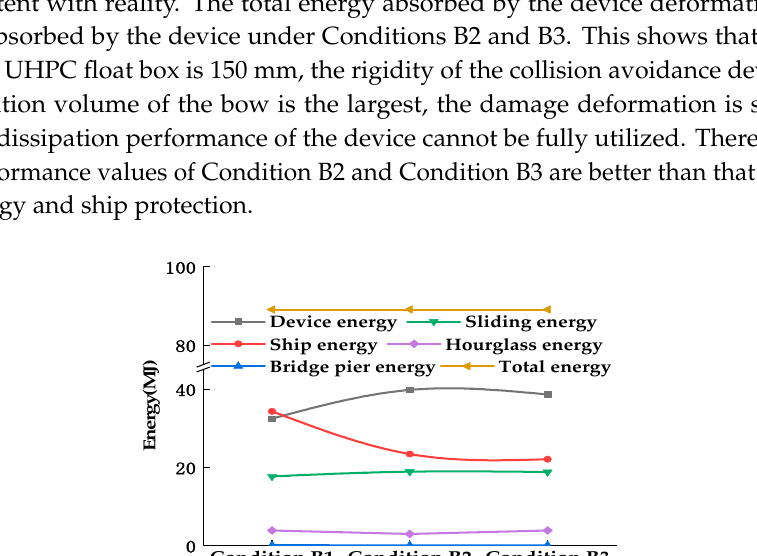
Figure 20. Energy comparison and summary of the three different wall thicknesses under protected conditions.